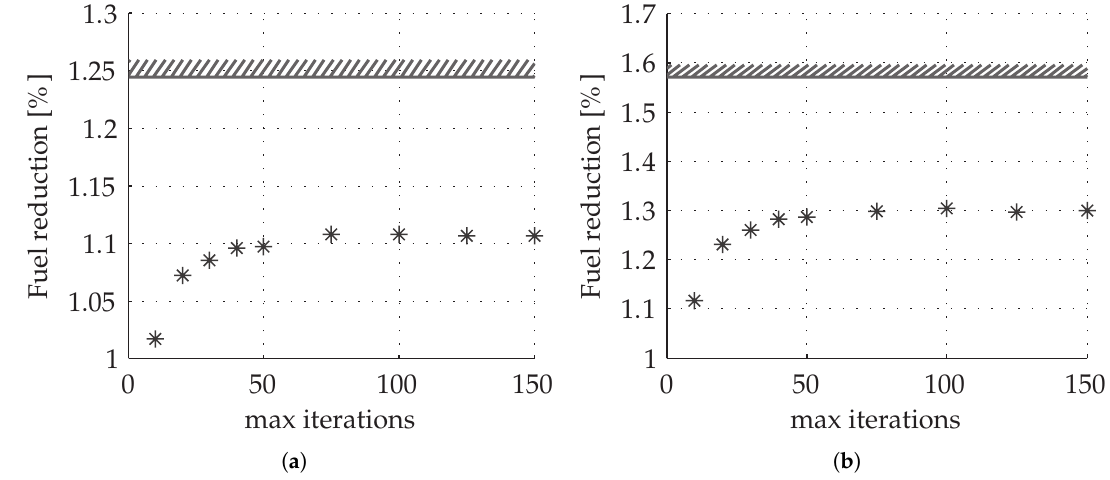
Figure 8. Fuel reduction as a result of smart control of auxiliaries with number of iterations being limited. ( a ) Part 1; ( b ) Part